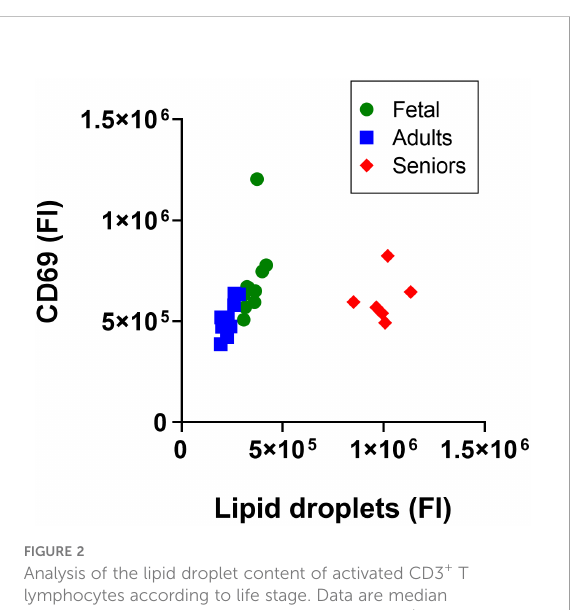
FIGURE 2 Analysis of the lipid droplet content of activated CD3 + T lymphocytes according to life stage. Data are median fl uorescence intensity by fl ow cytometry of CD3 + T lymphocytes from individual participants; Fetal T cells from umbilical cord, and adults and seniors. a.u., absorbance